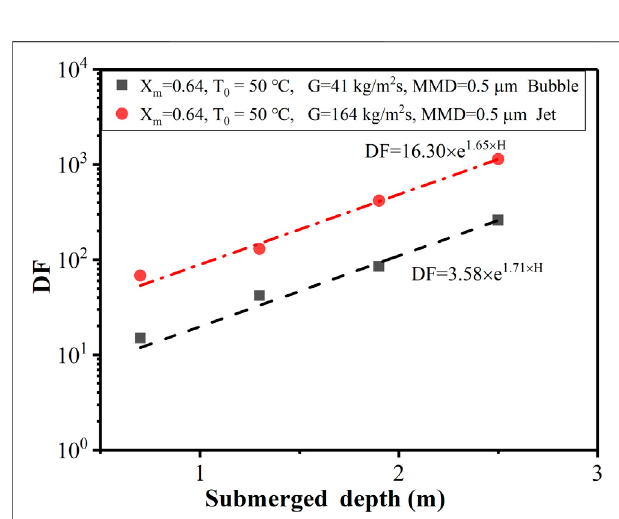
FIGURE 9 | Effect of submerged depth on